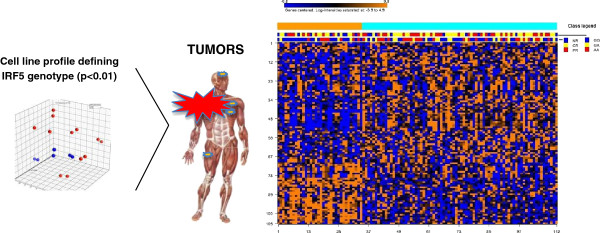
Cell lines predict tumor behavior, comparing AA vs GG. K mean clustering method organize heat map of melanoma metastases re-clustered based on 106 genes differentiating melanoma cell lines with distinct IRF5 genotype. On the right side of the panel, a subset of metastases significantly enriched in non-responders; on the left side of the panel, a set of cases that enriched in responders (Fisher test: p2-value = 0.025).